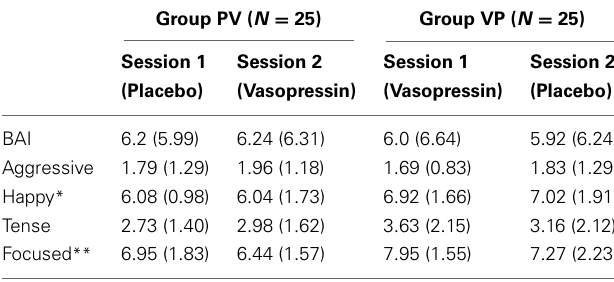
Table 5 | Means (and SD ) on scores on the Beck Anxiety Inventory and on selected scales of the adjusted Positive and Negative Affect Visual Analog Scale